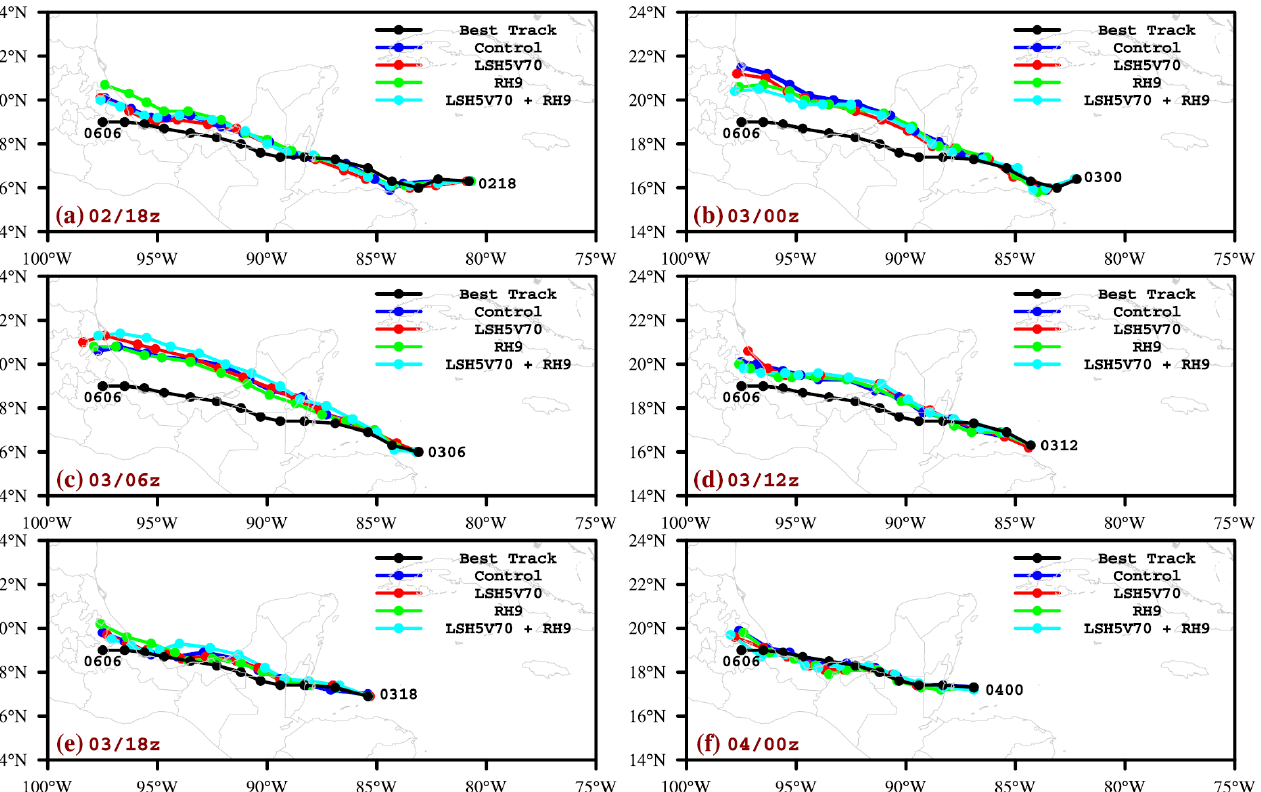
Figure 9. Comparison of the forecast track for Hurricane Earl from Control, LSH5V70, RH9, and LSH5V70 + RH9 at ( a ) 18 UTC 2, ( b ) 00 UTC 3, ( c ) 06 UTC 3, ( d ) 12 UTC 3, ( e ) 18 UTC 3, and ( f ) 00 UTC 4 August 2016.